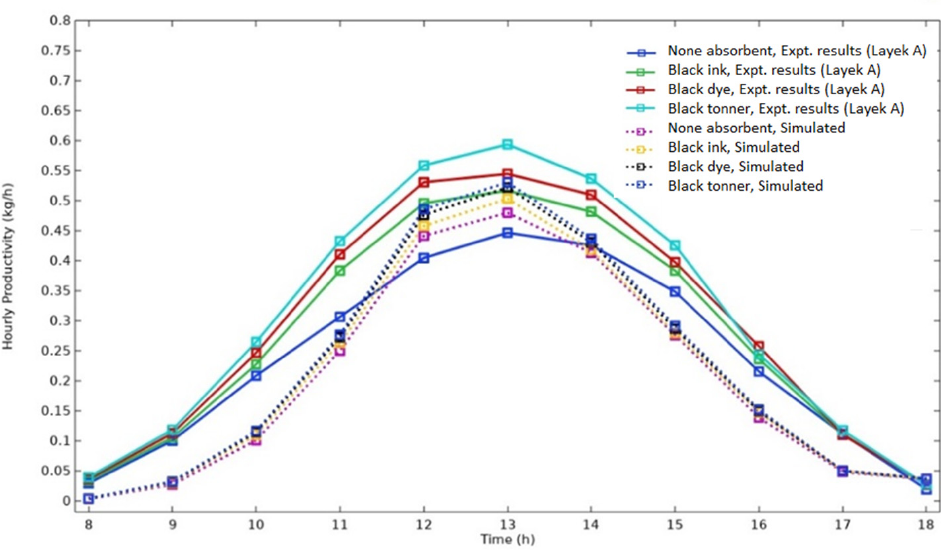
Figure 7. The hourly yield of the solar still.